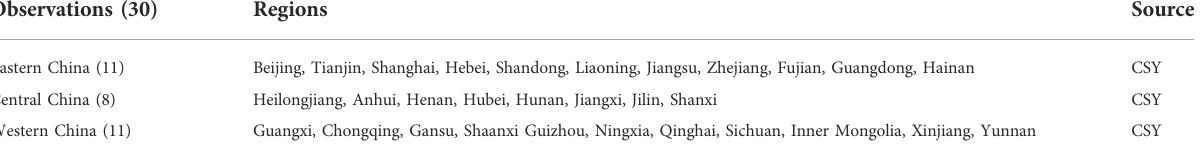
TABLE 2 The traditional division in China under investigation (excluding Tibet).